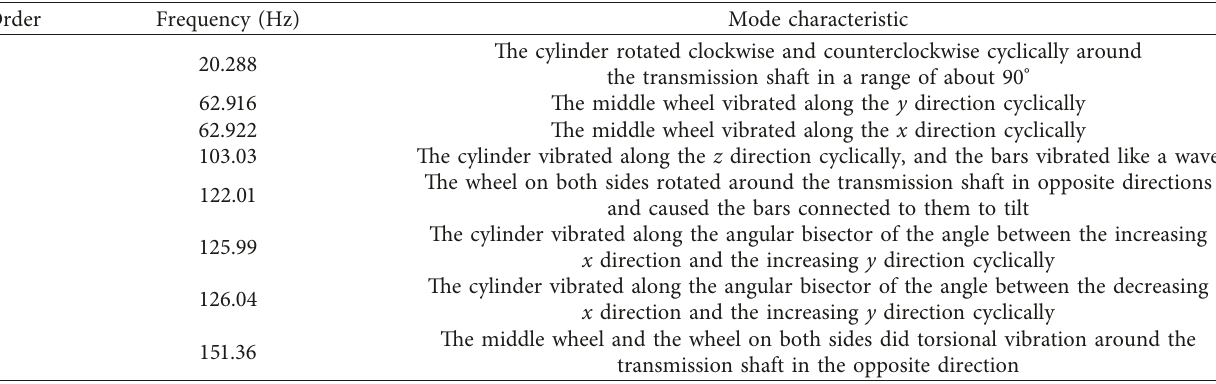
Table 4: Mode characteristics and frequencies of cylinder